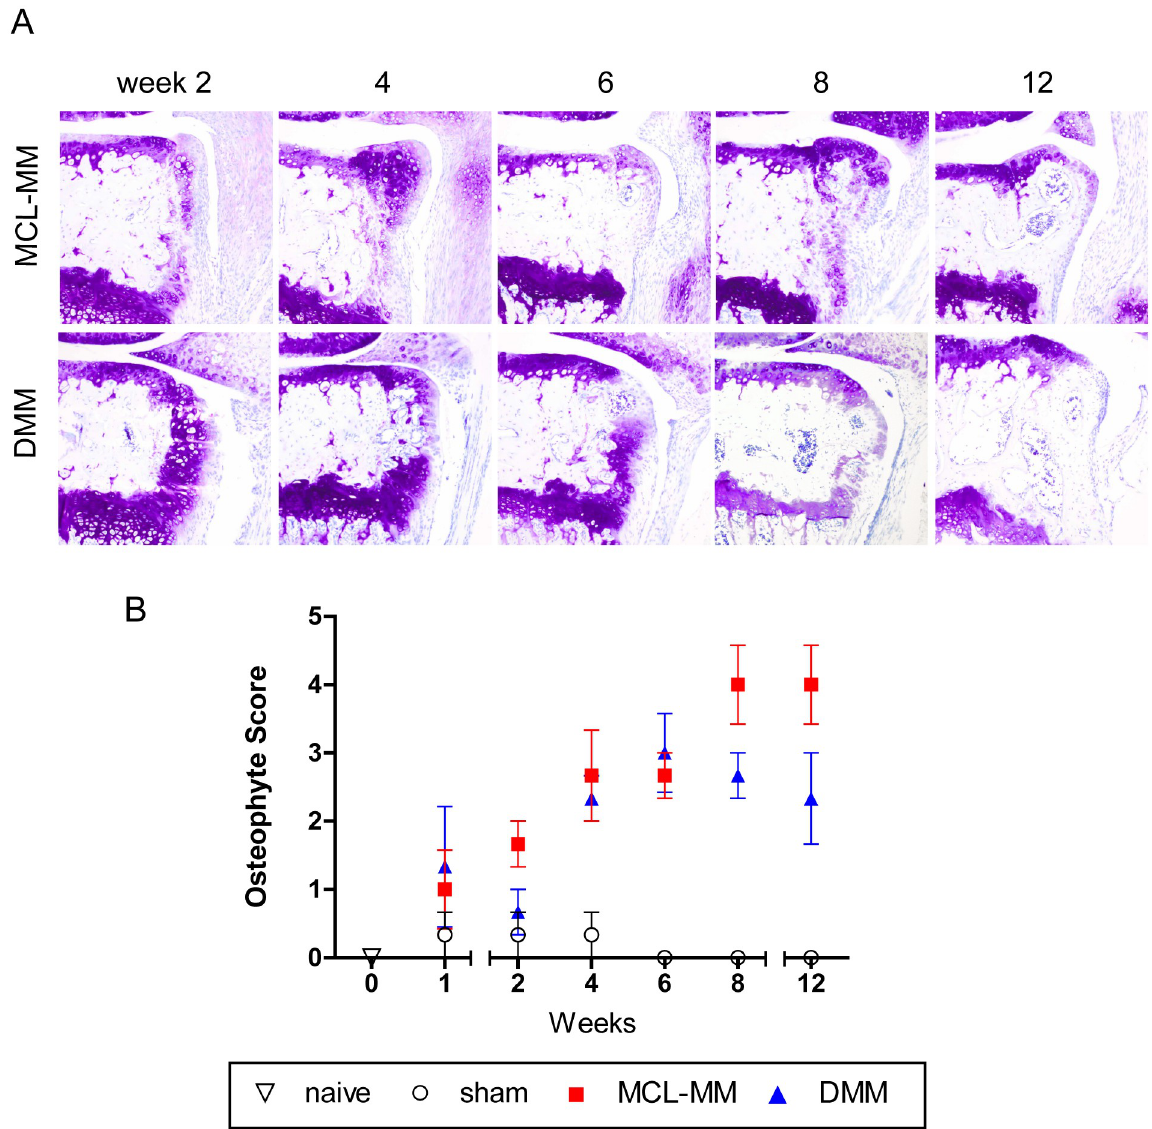
values ± SEM. Bar = 250 μ